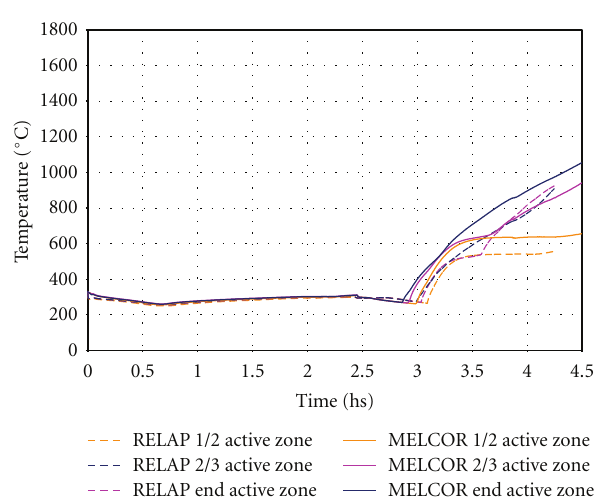
Figure 14: Cladding temperatures at di ff erent axial